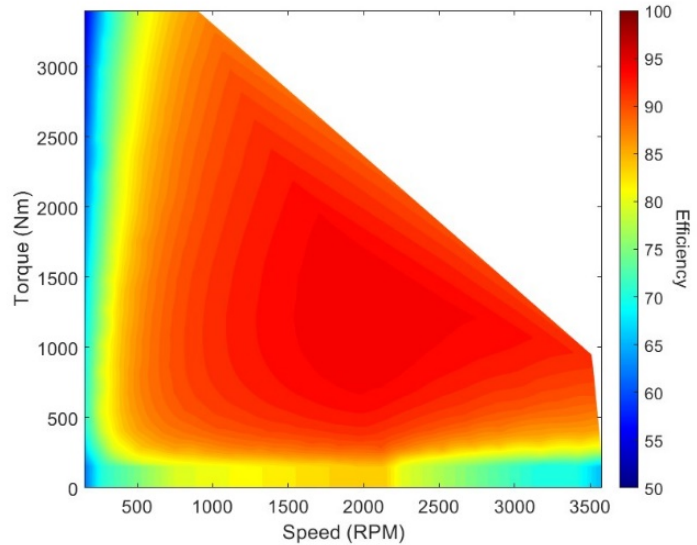
Figure 3. The electric motor efficiency map. Table 2. Battery pack parameters.